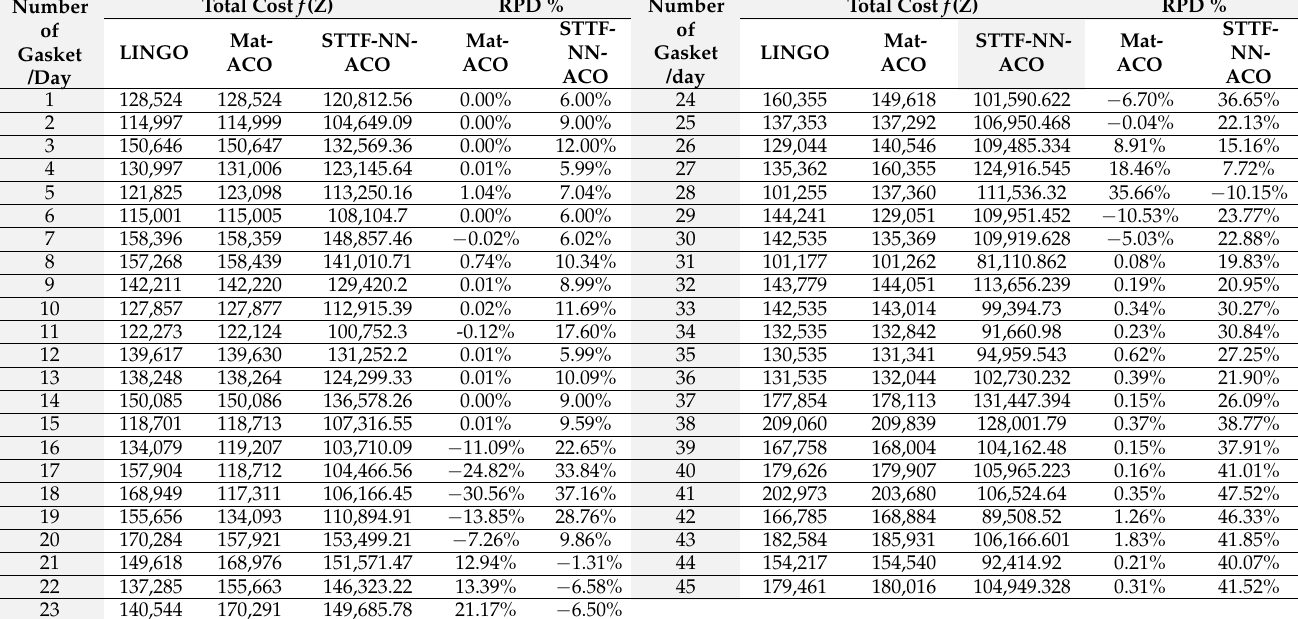
Table 5. Laboratory observations for gasoline consumption using LINGO and STTF-NN-ACO for transportation